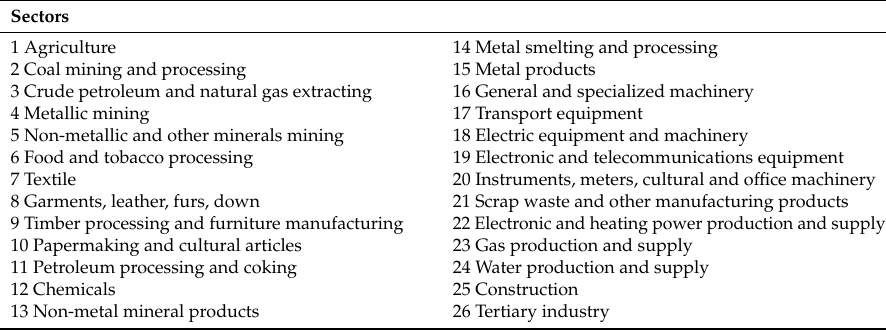
Table 1. Sectors of input–output